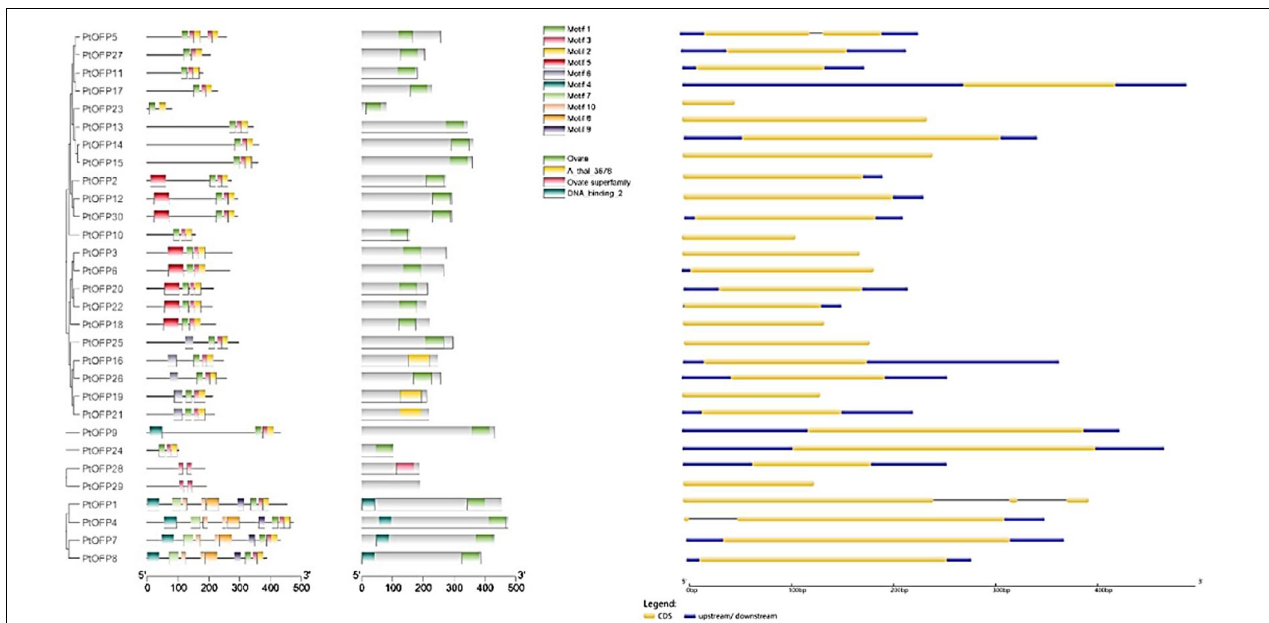
FIGURE 2 | PtOFP schematic representation motifs and genes structure. The motifs were identified by online MEME. Different-colored boxes show different motifs (Motifs 1 to 10) and their position in each PtOFP sequence. For exon/intron organization of PtOFP genes, yellow boxes represent exons and black lines with the same length represent introns. The upstream/downstream regions of PtOFP genes are indicated in blue boxes. The length of exons can be inferred by the scale at the